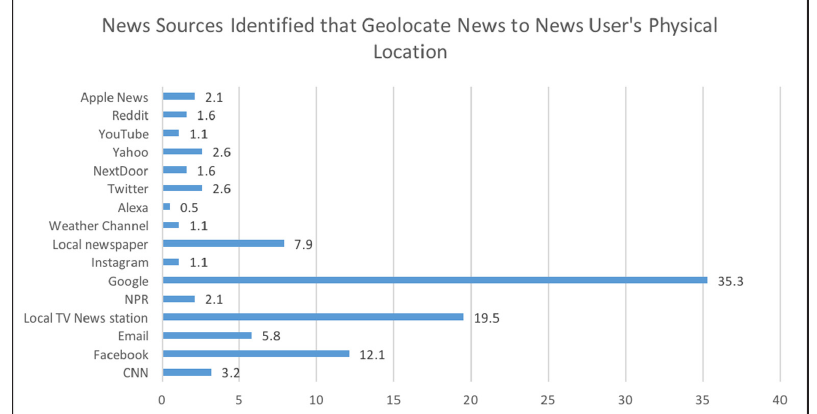
Figure 2: News Sources Identified that Geolocate News to News User’s Physical